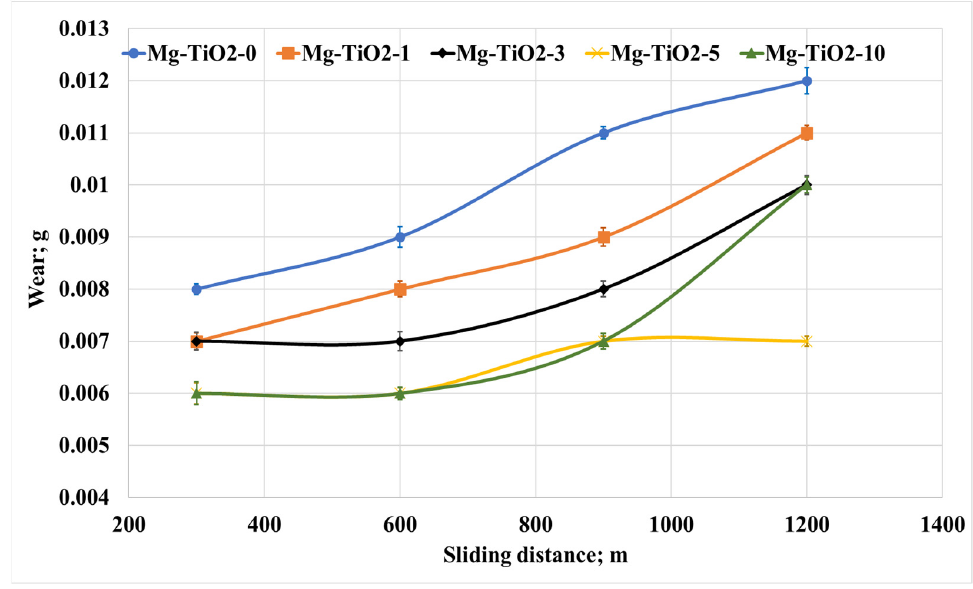
Figure 9. Wear of Mg/TiO 2 nanocomposites under different sliding distances, 30